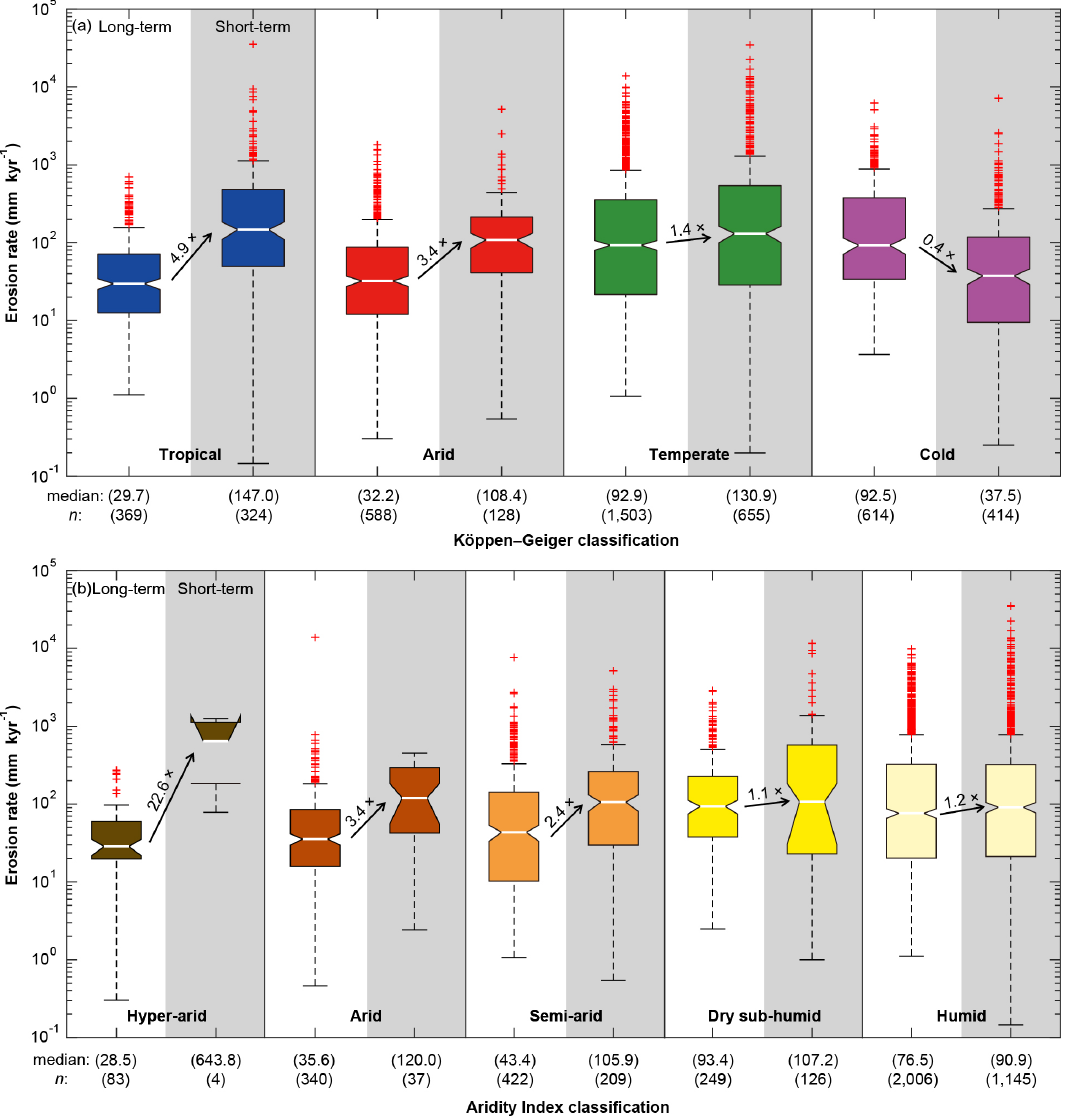
Figure 2. Long- and short-term erosion rates (all data) for climate zones of Köppen–Geiger climate classification (a) and Aridity Index classification (b) . Boxplots with white backgrounds contain the long-term rates, whilst those with the grey backgrounds contain short-term rates. For each box, the central line indicates the median value, whilst the bottom and top edges indicate the 25th and 75th percentiles, respectively. The notch represents the range of the median at the 95% significance level (note that the lower notch of short-term erosion rates of the Hyper-arid category extends beyond the range of the y -axis due to the limited number of samples in this category). Red crosses represent outliers. The arrows and numbers between boxplots in each climate zone indicate the trends and ratios of median values for short- to long-term rates ( R S / L ). Median values and the number of data points for each distribution are listed below the x